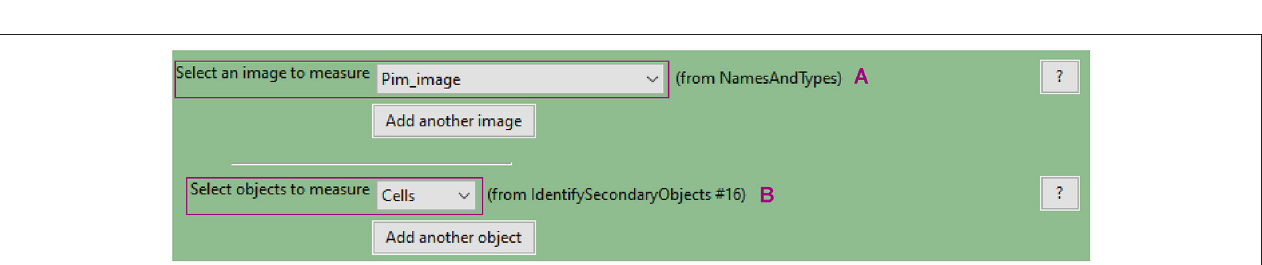
FIGURE 8 | CellProfiler “MeasureObjectIntensity” module interface. Parameters used to measure cell pimonidazole fluorescence signal for analysis shown in Figure 3 .